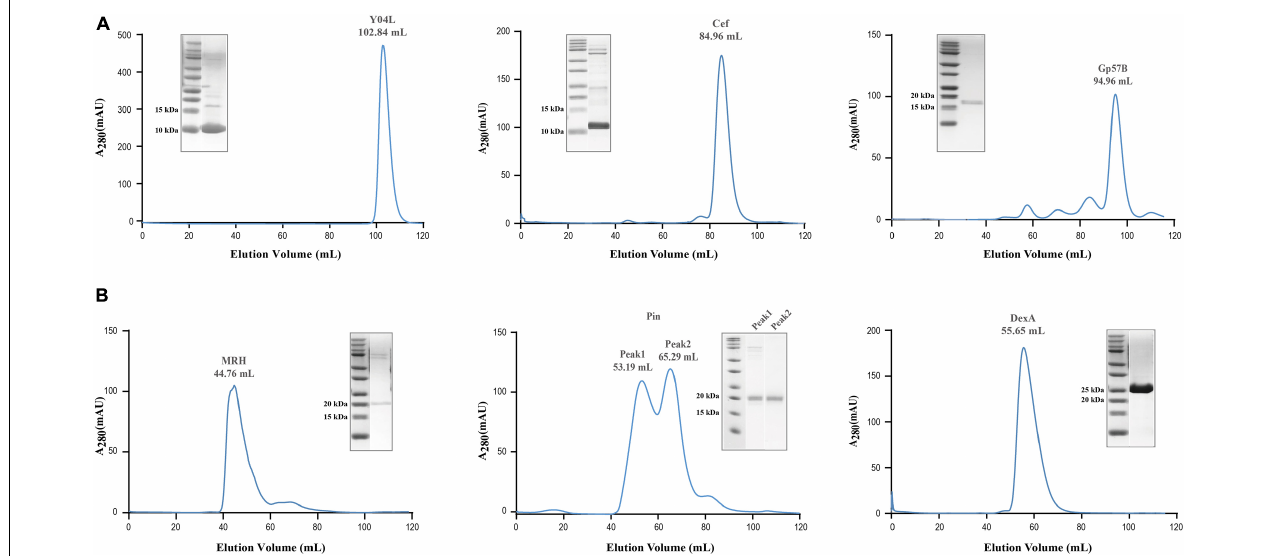
FIGURE 4 | Size exclusion chromatography of soluble viral proteins for assessment of multimeric state in solution. (A) Size exclusion chromatography of Pin, Y04L, Cef, and Gp57B demonstrated the viral proteins existed as a homogenous monomeric state in solution, shown by the absorption peak at the volume of the expected molecular weight. (B) Size exclusion chromatography of MRH and DexA demonstrated a homogenous multimeric state in solution, as the proteins eluted at a lower volume, indicating a larger molecular weight. The chromatographies of Y04L and Gp57B were performed using HiLoad 16/600 Superdex 200 pg while the experiments of Cef, MRH, Pin, and DexA were using HiLoad 16/600 Superdex 75